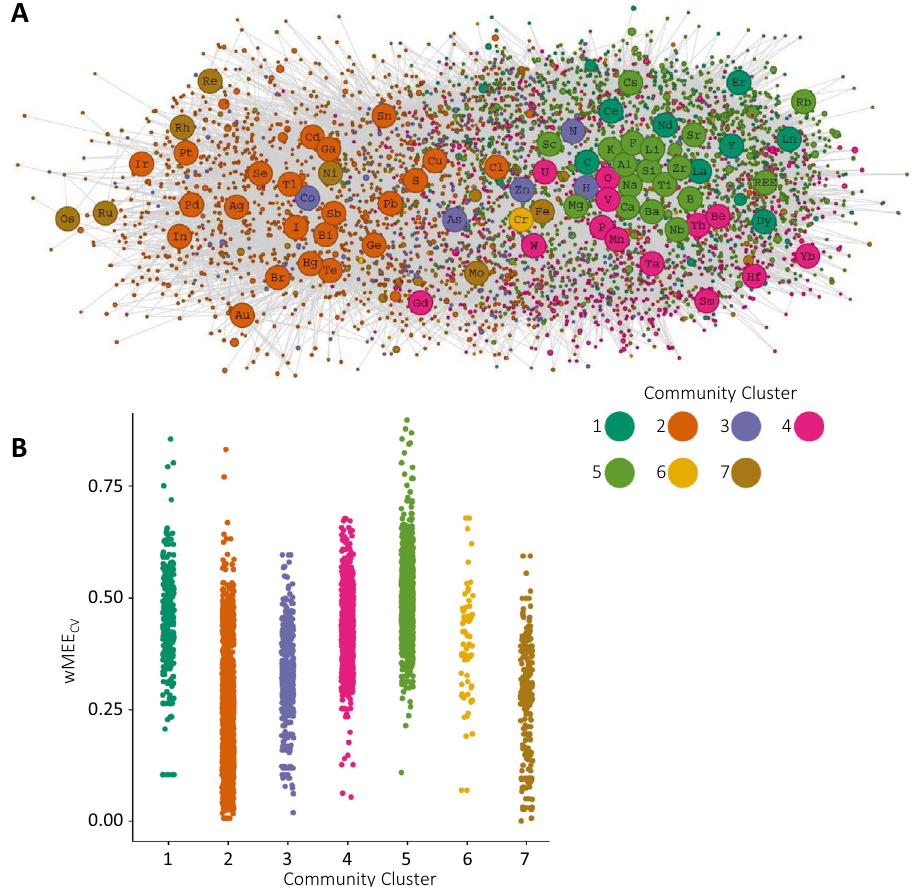
Figure 2. Full mineral chemistry network wMEE CV clustering. ( A ) Bipartite mineral chemistry network containing all known minerals and their constituent elements (same network as Fig. 1) with minerals and elements colored by Louvain community detection cluster 25 . ( B ) A plot of weighted Mineral Element Electronegativity Coefficient of Variation (wMEE CV ) separated by Louvain community cluster. The wMEE CV values of nearly all network clusters are statistically different from each other by Tukey Test. The only clusters that are not statistically different from each other are clusters 1 and 6, 4 and 6, and 2 and 7 (Supplementary Table S1). Figure created using dragon version 1.1.0 (https:// github. com/ sjspi elman/